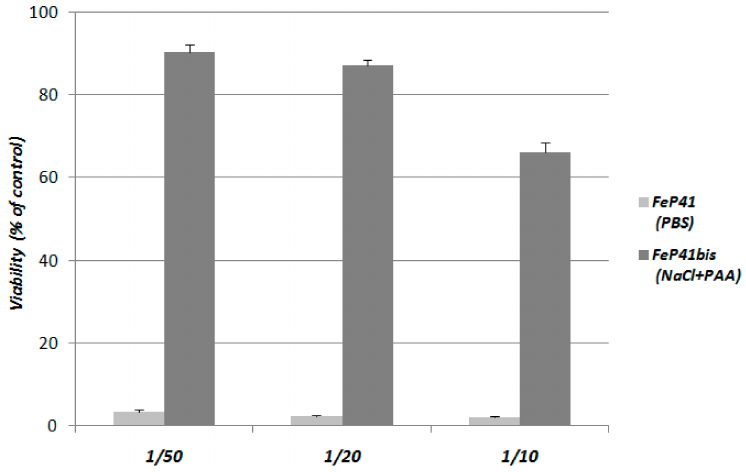
Figure A1. Viability of Luc-expressing U87 cells in the presence of Fe-PEI NPs prepared in PBS (FeP 41) and PAA/NaCl solution (FeP41 bis). NPs were diluted in complete culture medium at various